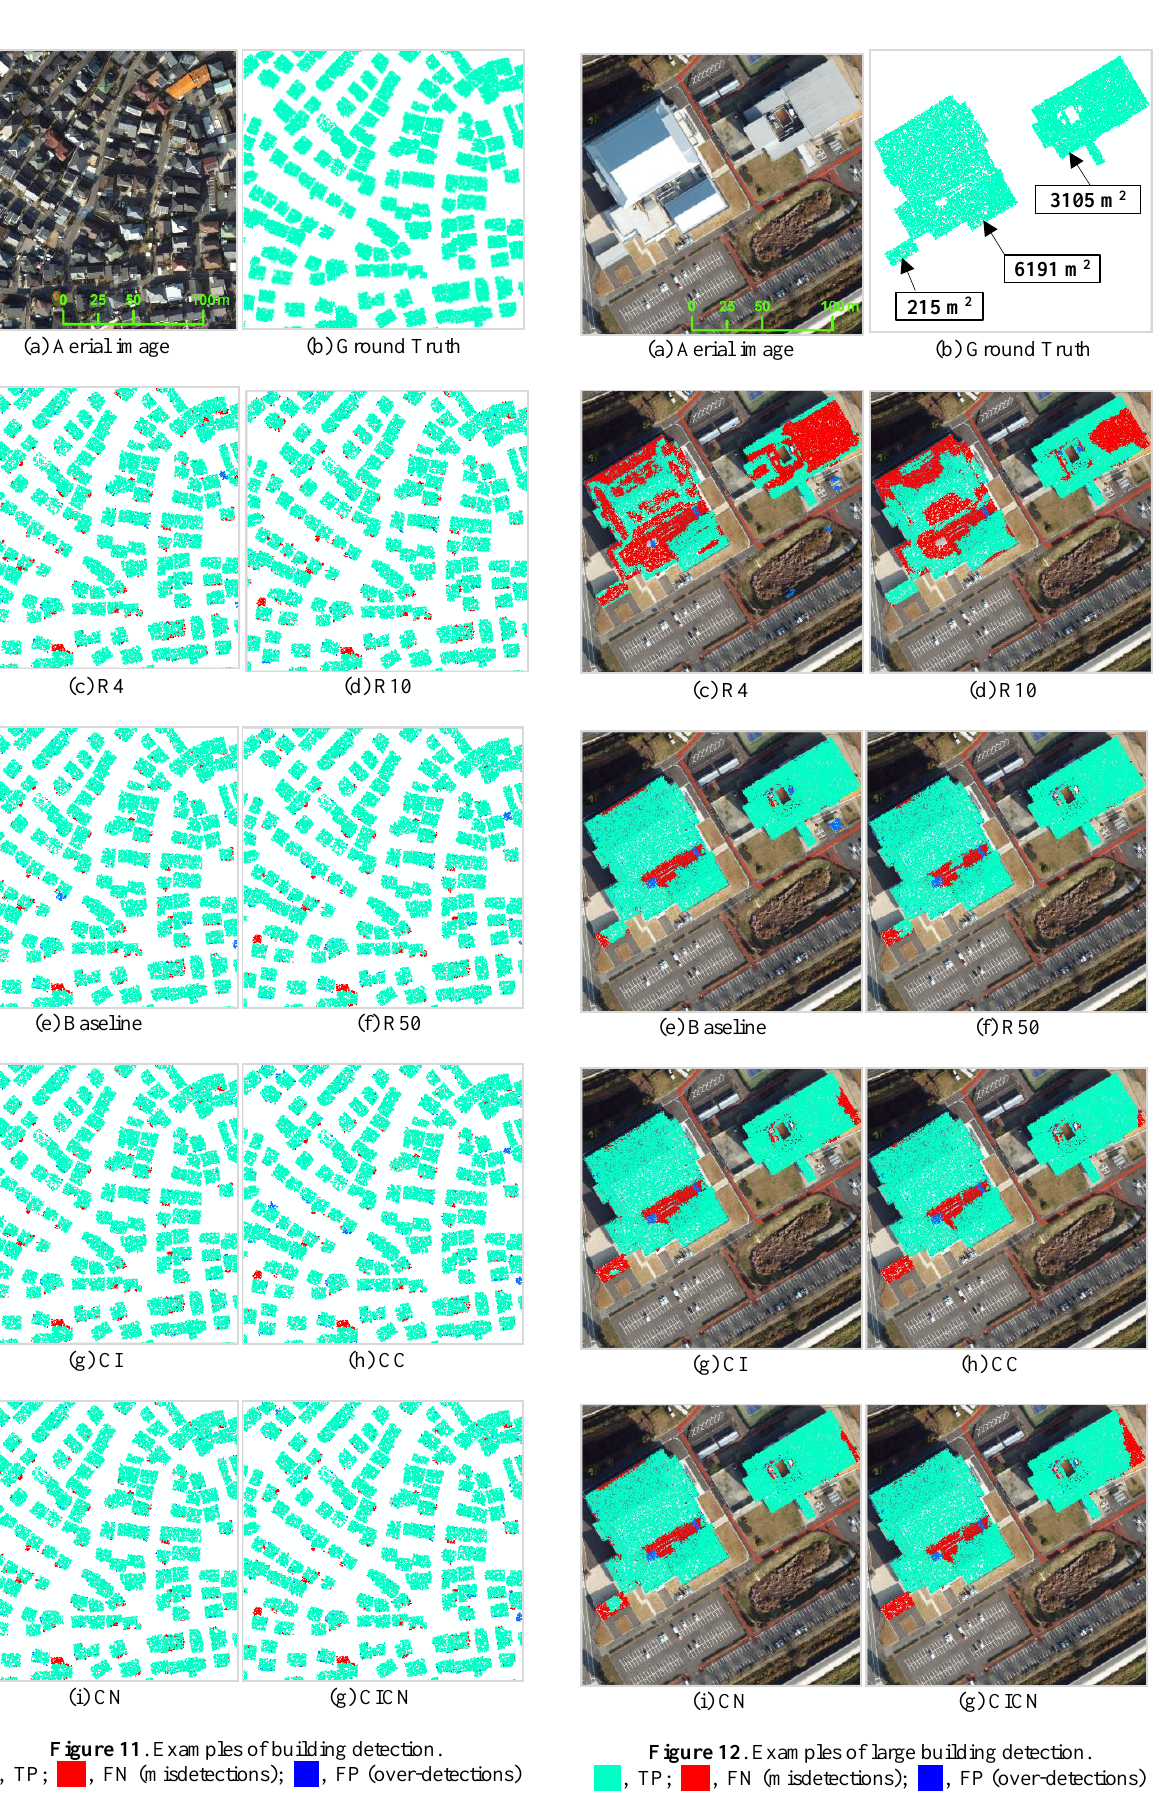
Figure 12 . Examples of large building